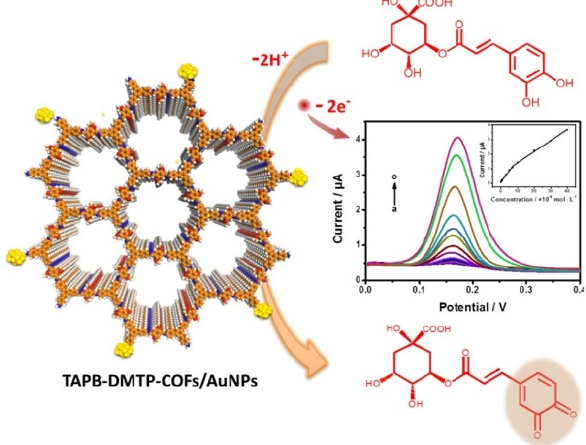
Figure 10. Schematic representation of GCA detection at TAPB-DMTP-COFs/AuNPs/GCE. Reprinted with permission from [103]. Copyright 2018, Elsevier.